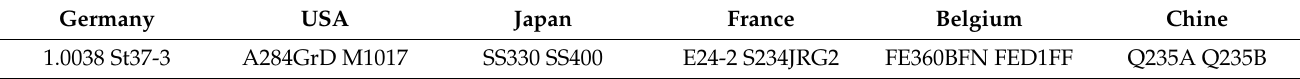
Table 1. International analogues of St3sp grade